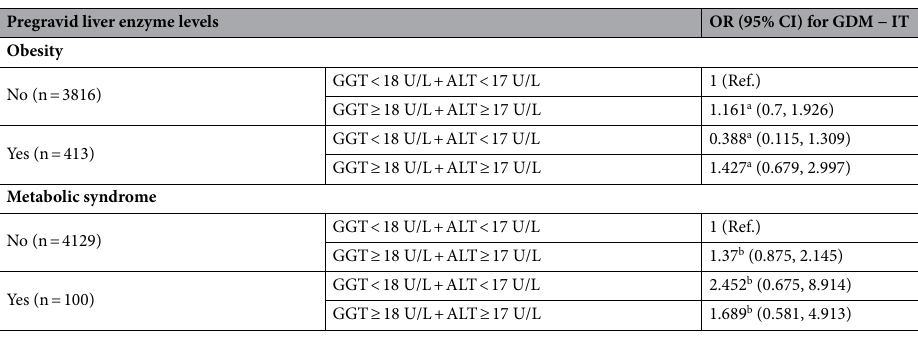
Table 5. GDM − IT risks in a subsequent twin pregnancy, according to pregravid liver enzyme levels, obesity and metabolic syndrome. a Adjusted for maternal age, parity, smoking, alcohol consumption, income level, exercise status, and metabolic syndrome. b Adjusted for maternal age, parity, smoking, alcohol consumption, income level, exercise status, and BMI. ALT alanine aminotransferase, GDM gestational diabetes mellitus, GGT gamma-glutamyltransferase, OR odds ratio, CI Confidence interval. Non-GDM pregnant women without GDM, GDM − IT GDM pregnant women without insulin